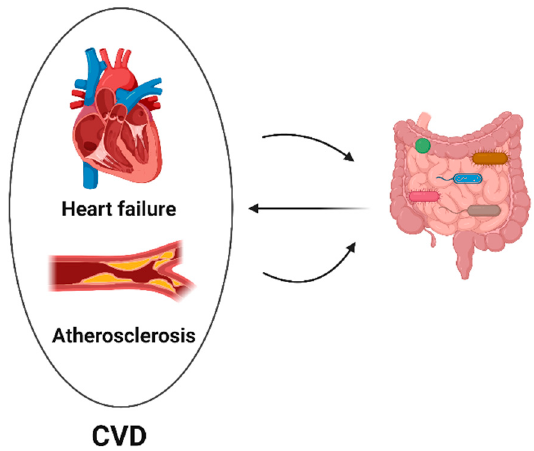
Figure 2. Crosstalk between cardiovascular disease and gut microbiota. Various microbes in the gut are represented with different colors. (This Schematic representation was created using Biorender (https://biorender.com/)).